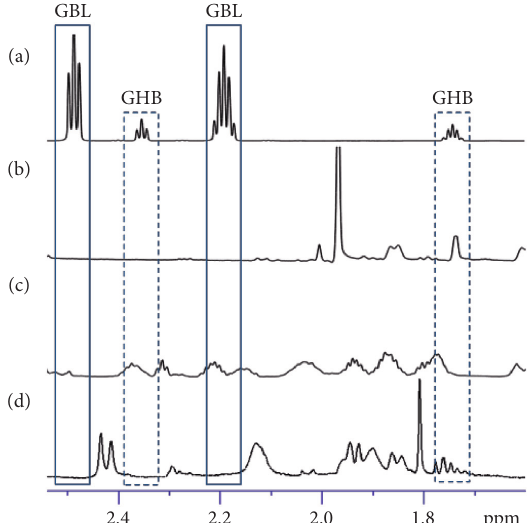
Figure 2: The local enlarged 1H-NMR spectrum of GBL spiked into 0.2% aqueous solution of formic acid (a), fruit vinegar drink (b), orange juice (c), and coffee drink